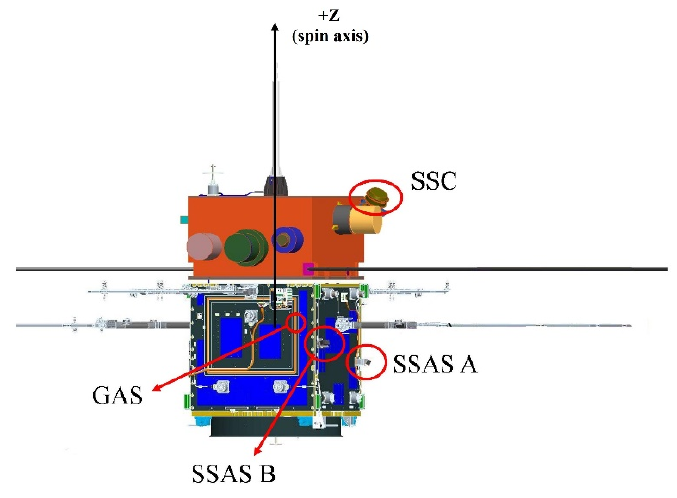
Figure 2. Attitude Figure 2. Attitude sensors.